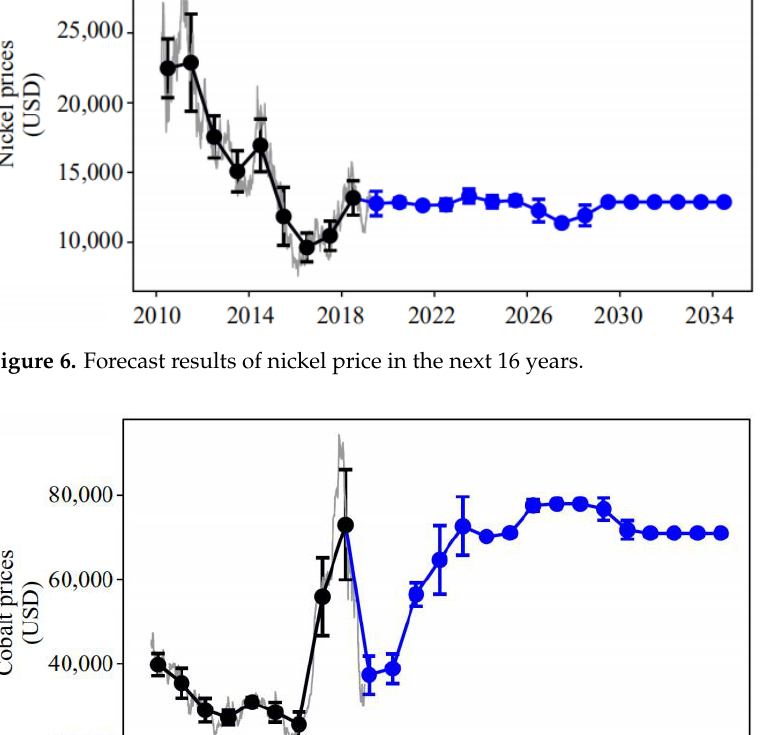
forecast value of medium and long-term prices, and the circle represents the annual price, the square represents the forecast price with error analysis.